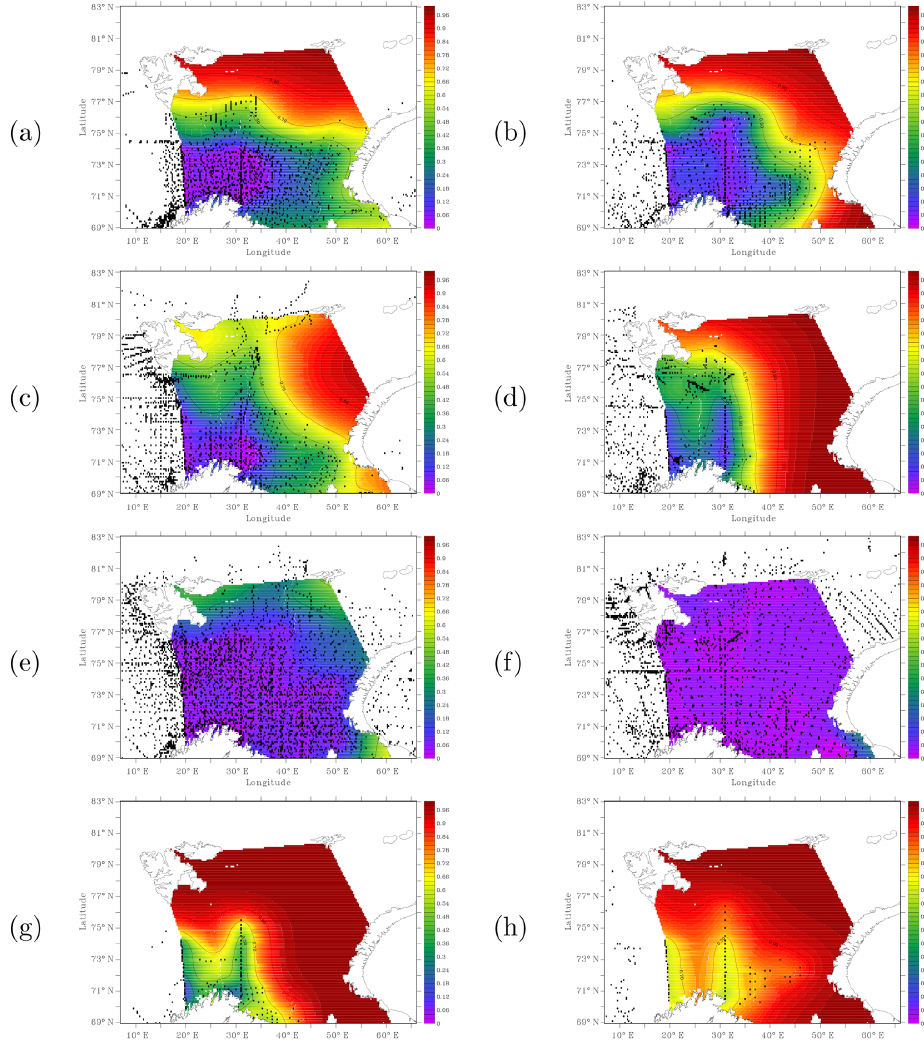
Figure 4. Average relative error for temperature at the Barents Sea surface between 1994–1998 (left column) and 2006–2010 (right column) between 1994 and 1998. Panels (a) and (b) correspond to spring, (c) and (d) to summer, (e) and (f) to autumn, and (g) and (h) to winter. This variable measures the added value brought by in situ data to the analysis: 0 would be the true field while 1 corresponds to an absence of data, that is an analysis equal to the first guess. The winter 1996–1997 was excluded from the computations due to a lack of